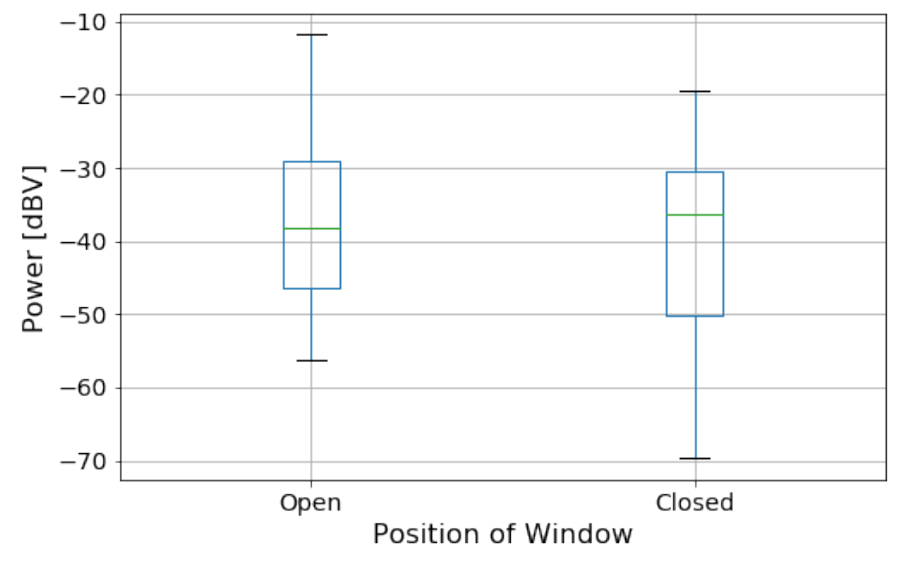
Figure 10. Box plot of data divided by the state of the car windows.